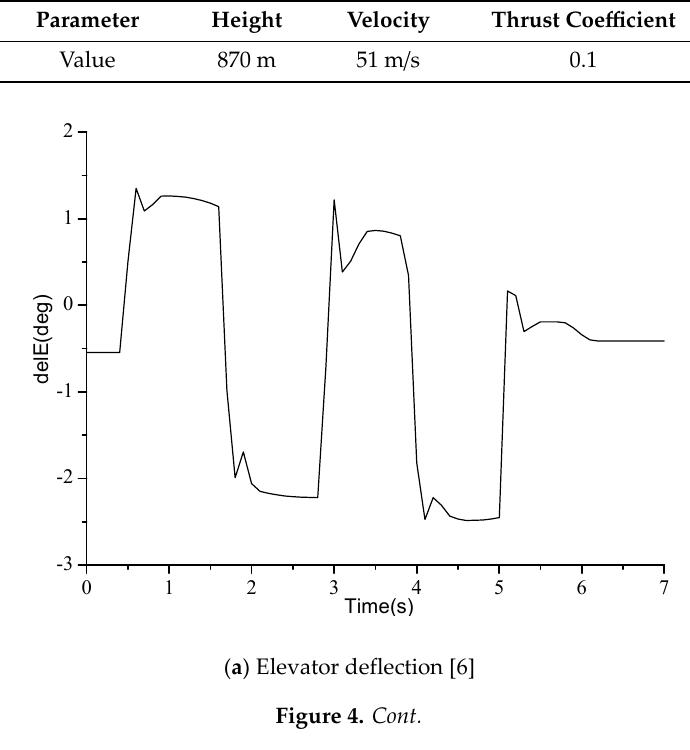
Table 3. Initial flight conditions of clean aircraft.